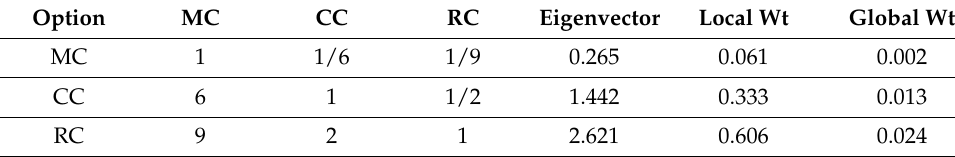
Table A8. Comparison of alternatives matrix for subcriterion SA4.